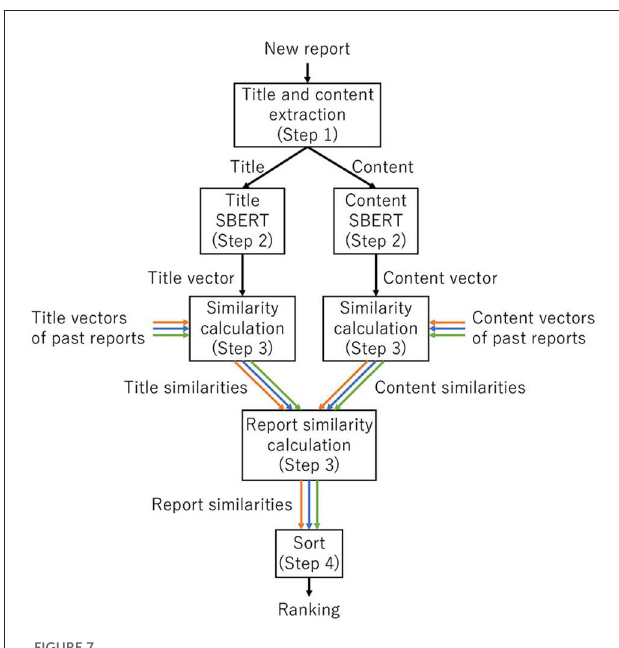
FIGURE7 Overview of the flow in proposed